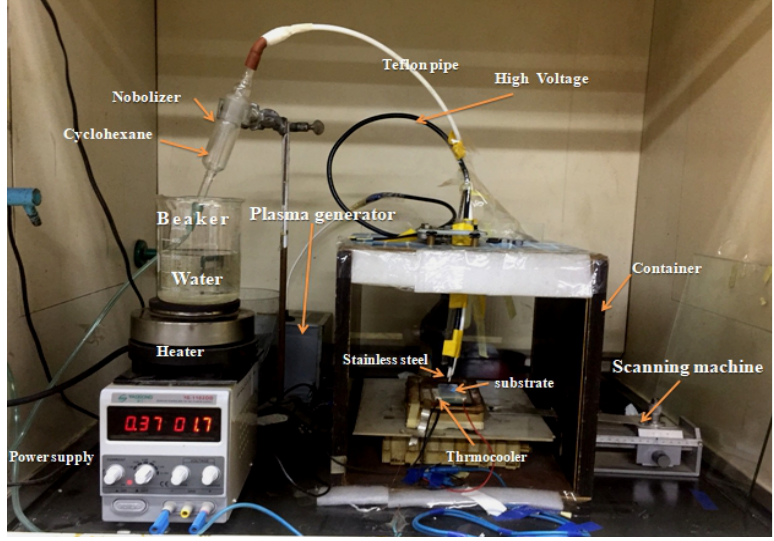
Fig.1: Image of the plasma jet